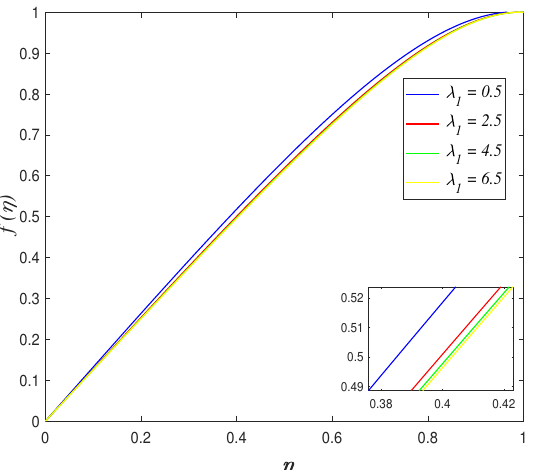
Figure 6. Impact of λ 1 on radial velocity.